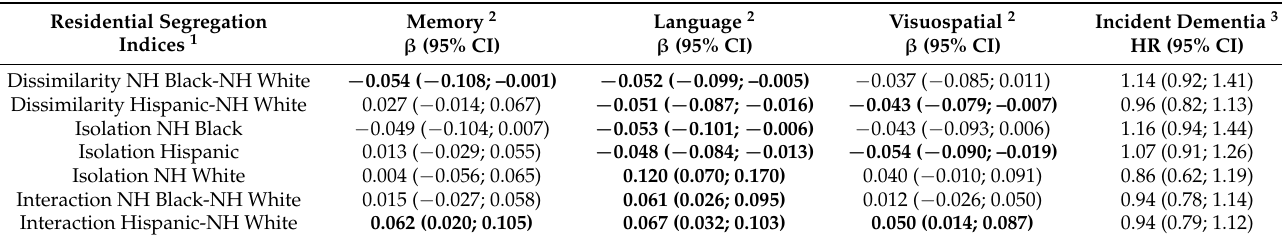
Table 2. Results of multilevel linear or Cox models estimating the association of residential segregation with later life cognitive abilities or incident dementia. Estimates for which the 95% confidence intervals do not include the null are highlighted in